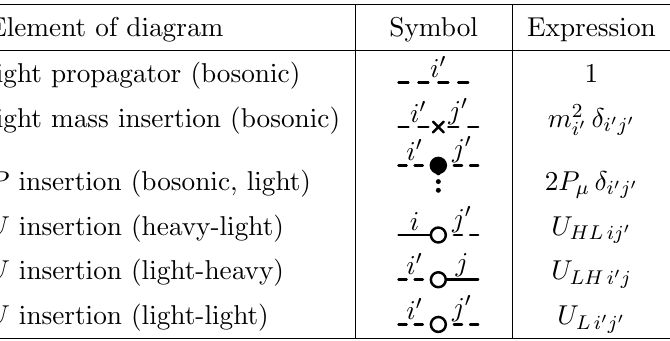
Table 1 . Building blocks of covariant diagrams for integrating out heavy bosonic (cid:12)elds (and fermionic (cid:12)elds as well if one follows the approach of eq. (3.19) to square their quadratic operator), in the absence of mixed heavy-light contributions and open covariant derivatives in the X matrix, as derived in section 3.1. All previous universal results in the literature [4, 8] can be easily reproduced by computing one-loop covariant diagrams built from these elements; see section 4.1.